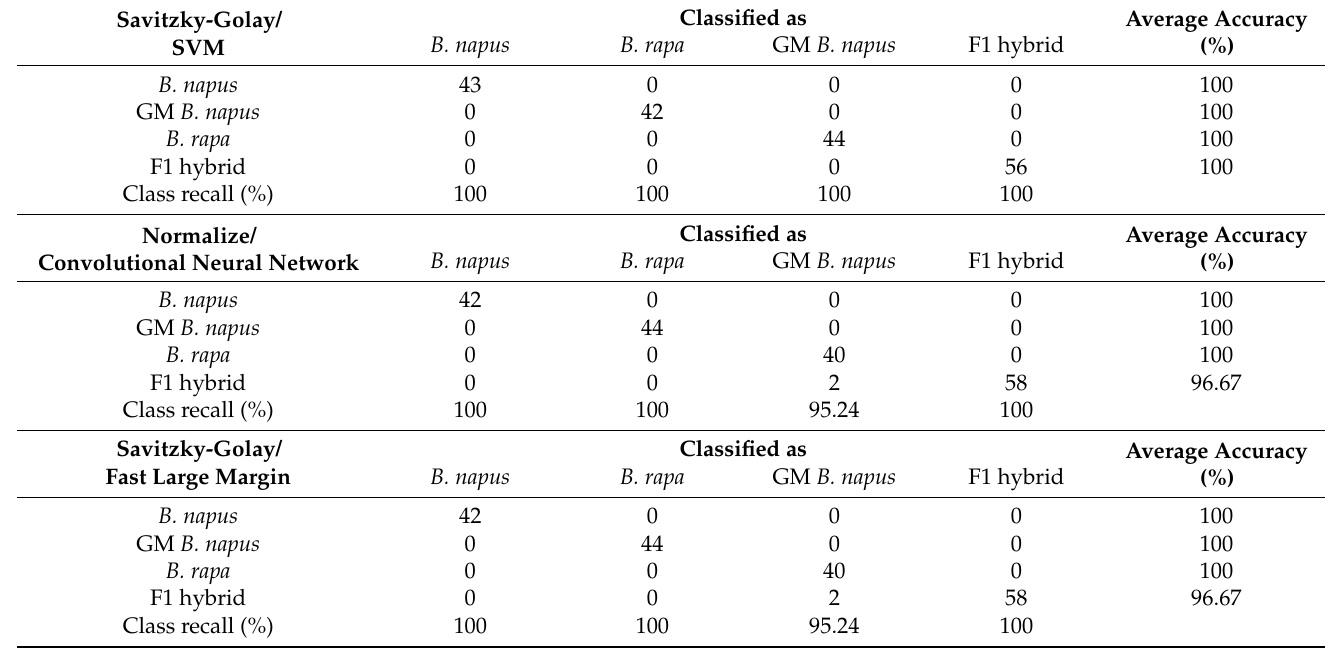
Table 4. Confusion matrix of species discrimination using better performing combinations of prepro- cessing methods and models.